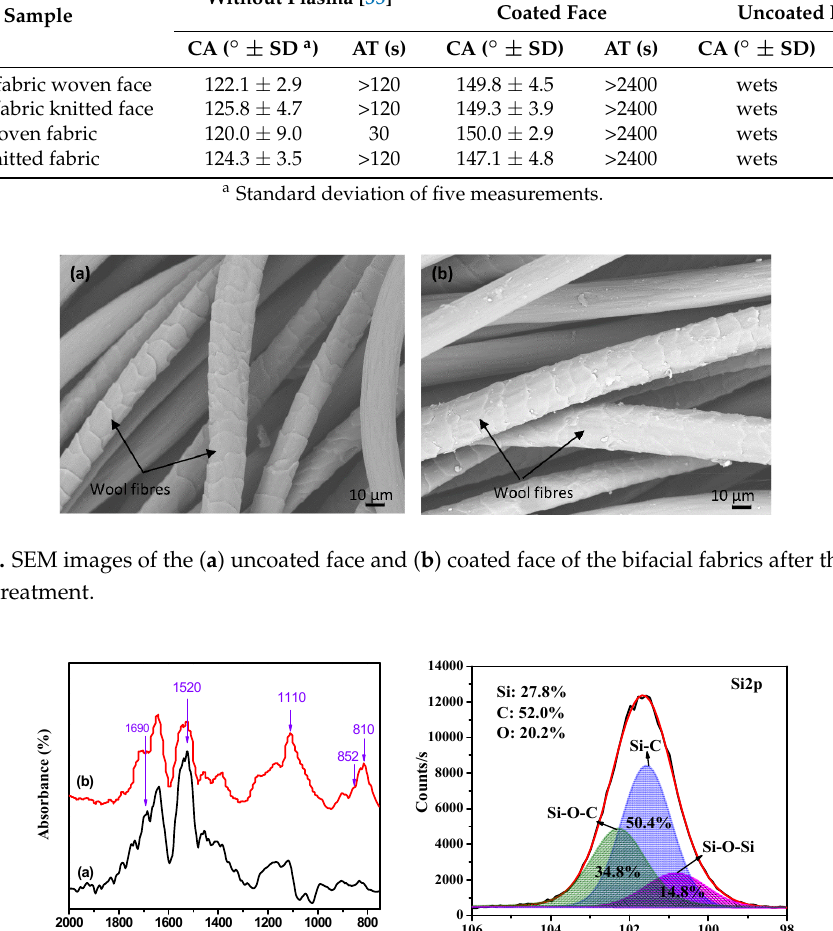
Table 2. Comparisons of the contact angle (CA) and absorption time (AT) before and after 3 steps plasma treatment. plasma treatment. plasma treatment.